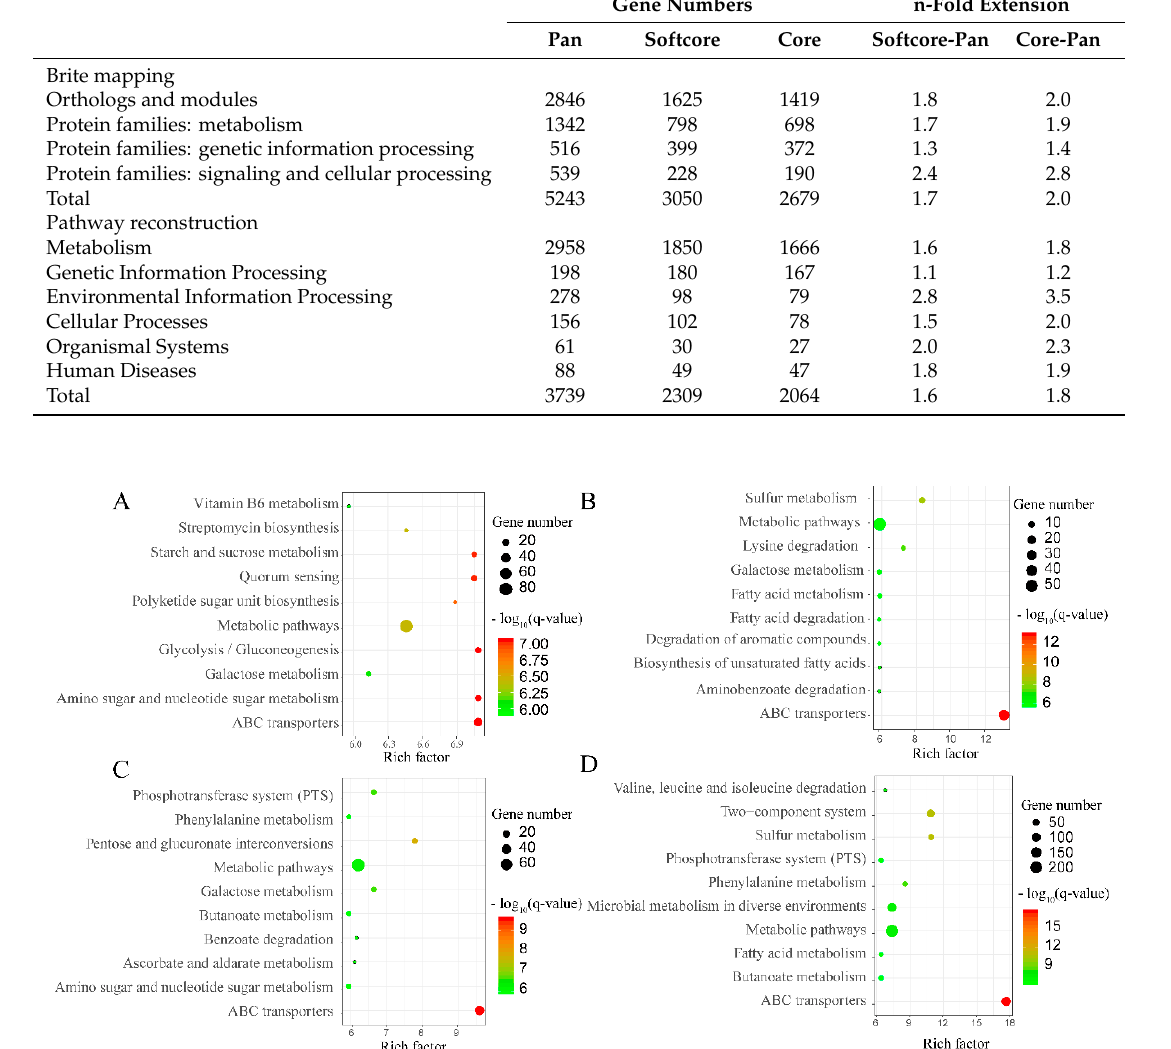
Gene Numbers n-Fold Extension Pan Softcore Core Softcore-Pan Core-Pan